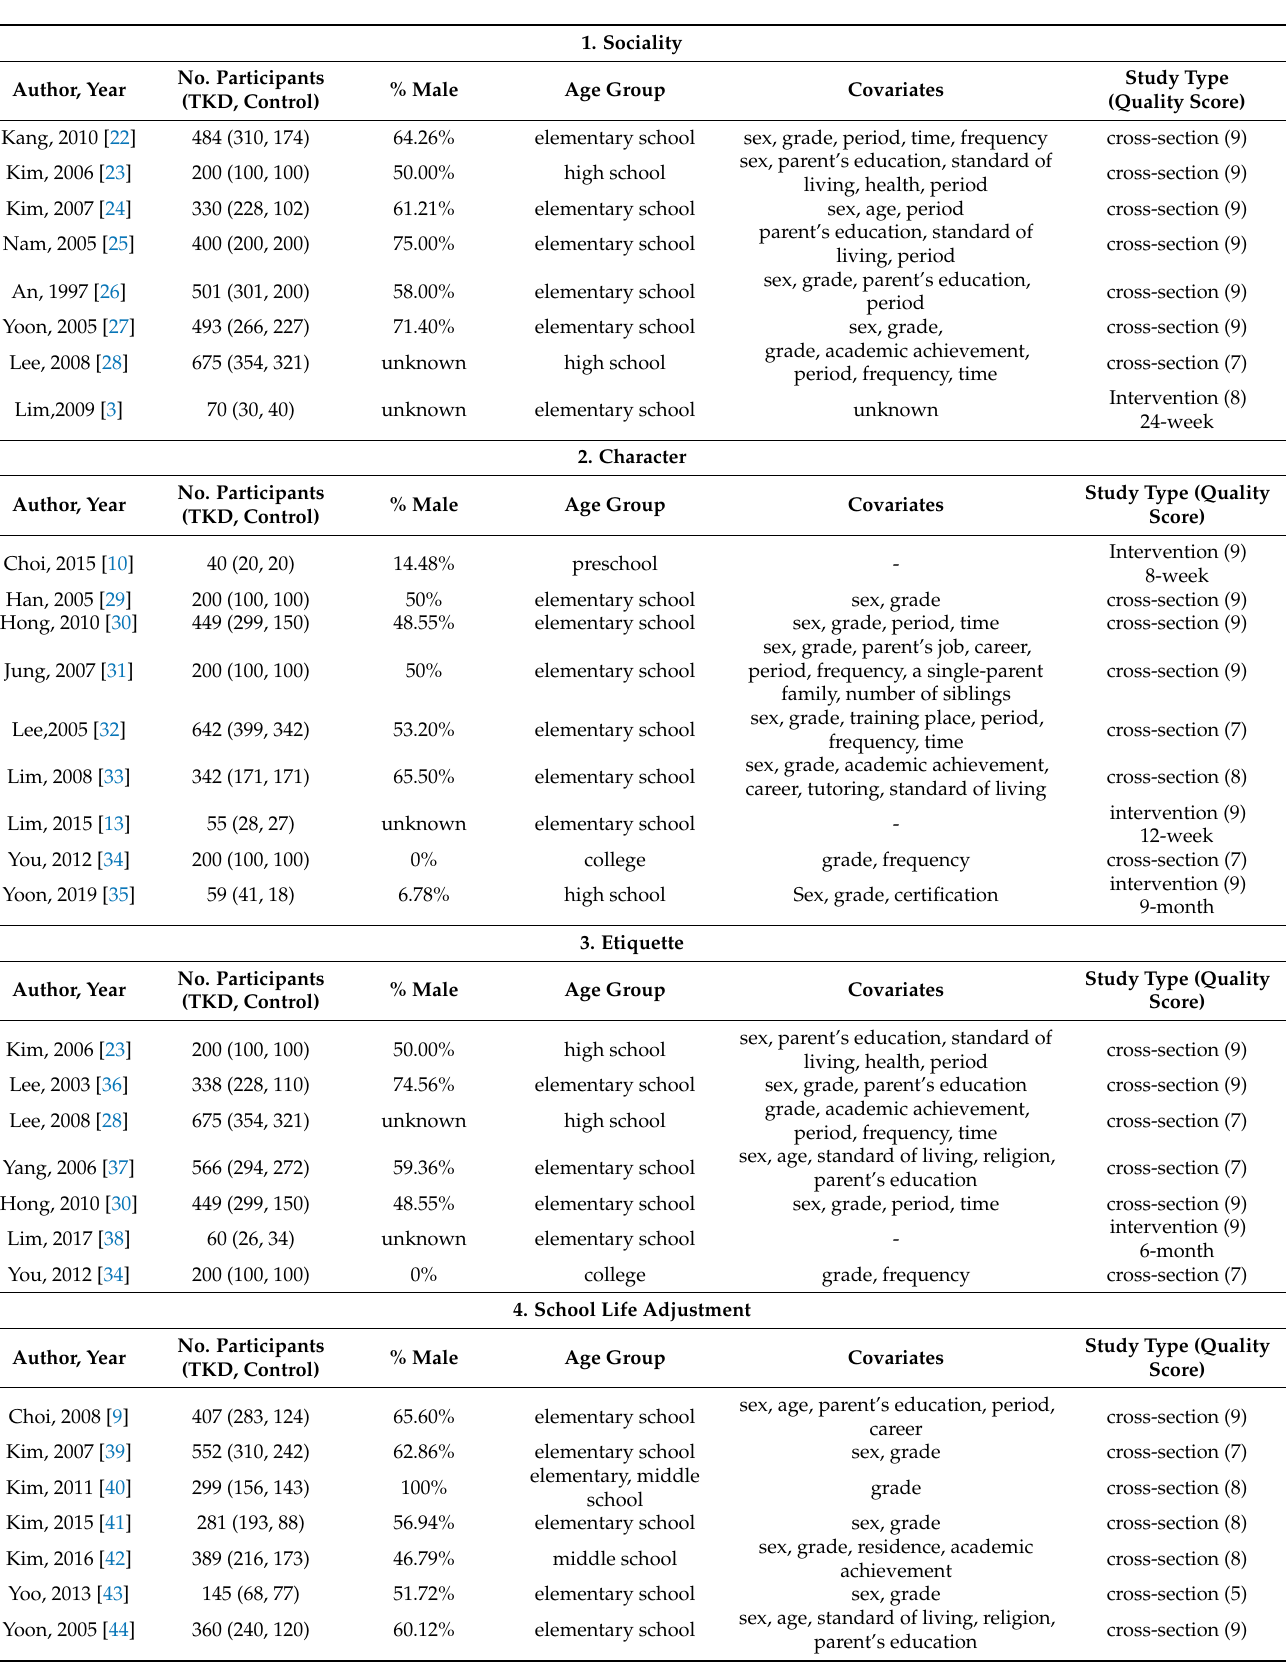
Table 1. Characteristics of included